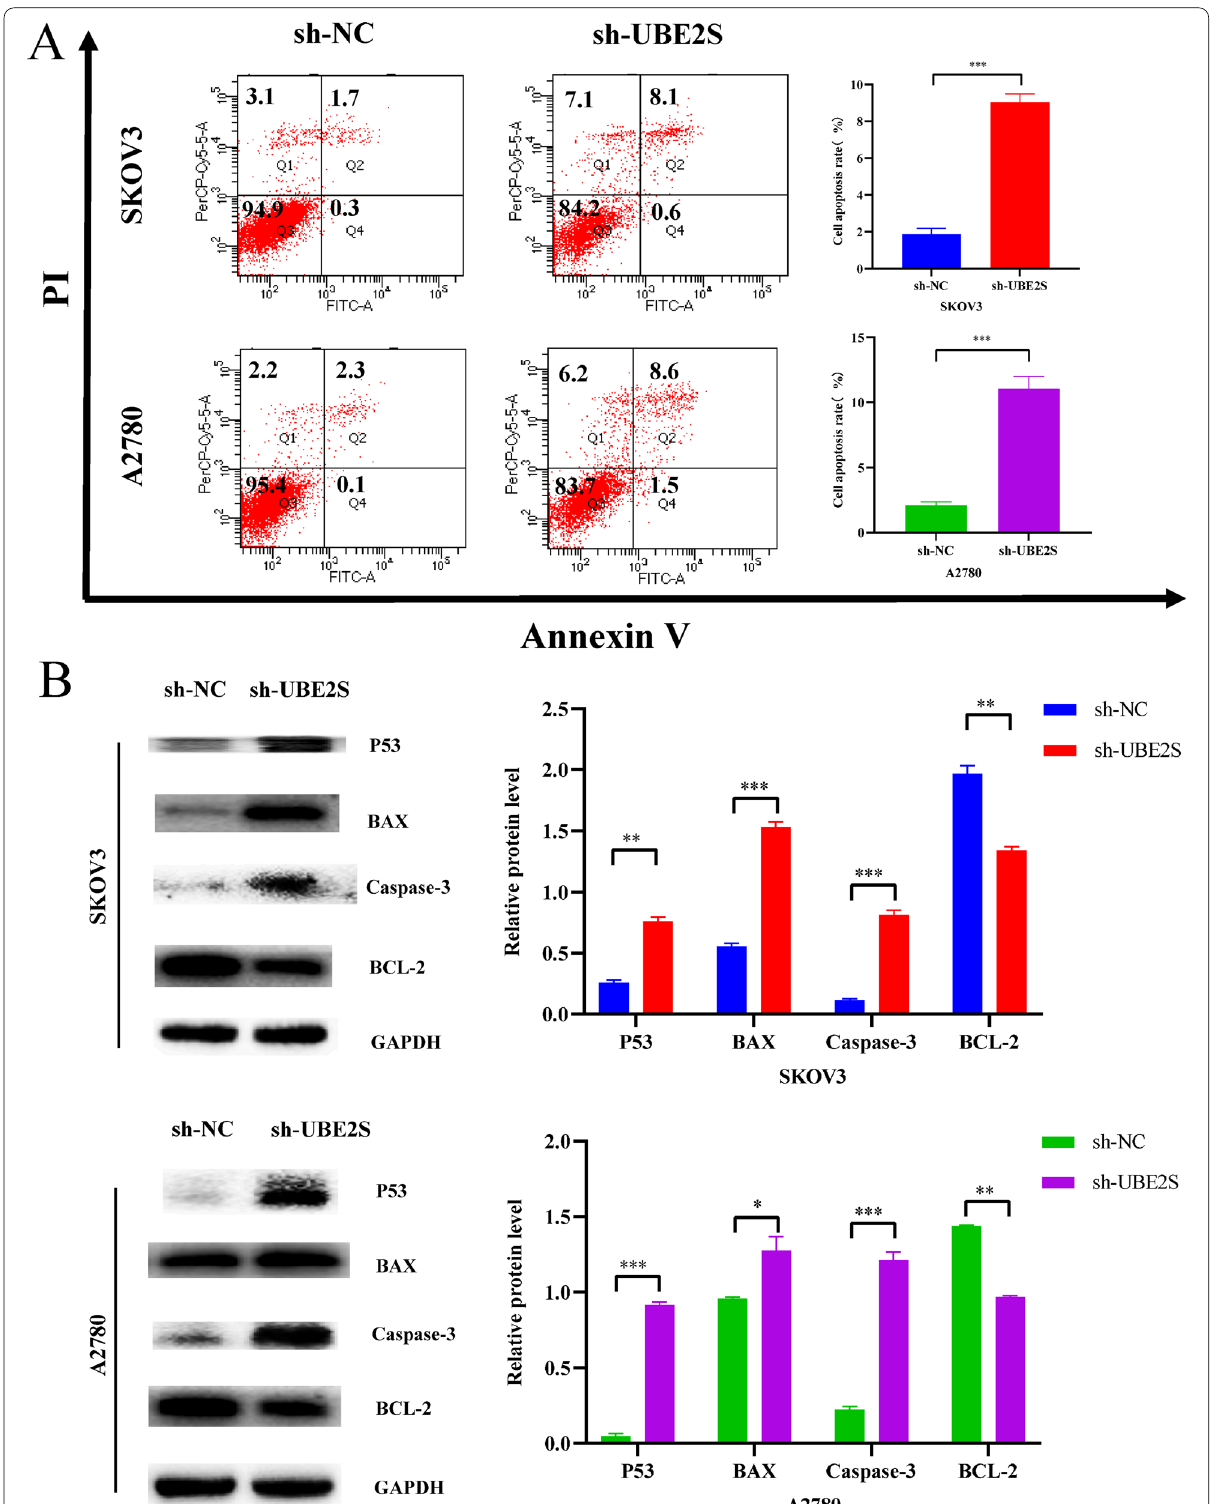
Fig. 11 Effects of UBE2S gene knockdown on apoptosis. A Flow cytometry results and statistics related to apoptosis of ovarian cancer cells in SKOV3 cells and A2780 cells. B Western blot results and statistics of apoptosis-related proteins in SKOV3 cells and A2780